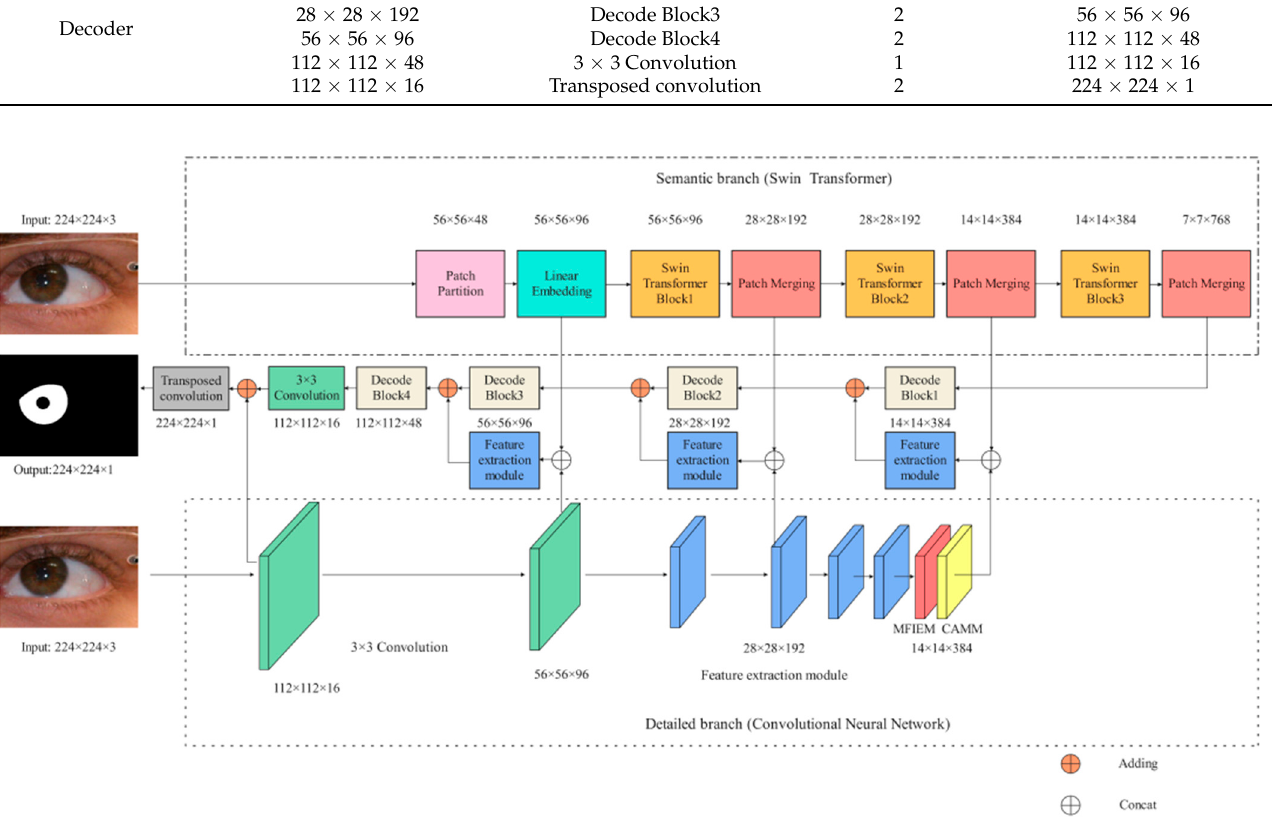
Figure 1. The iris segmentation network proposed in this paper (MFIEM: Multiscale feature information extraction module, CAMM: Channel attention mechanism module).